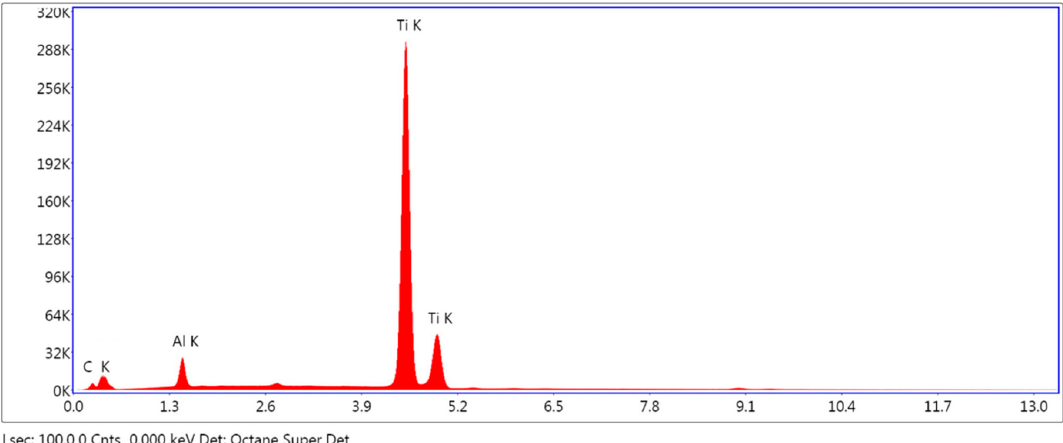
Figure 11. Energy dispersive spectroscopy analysis of HA + AW.